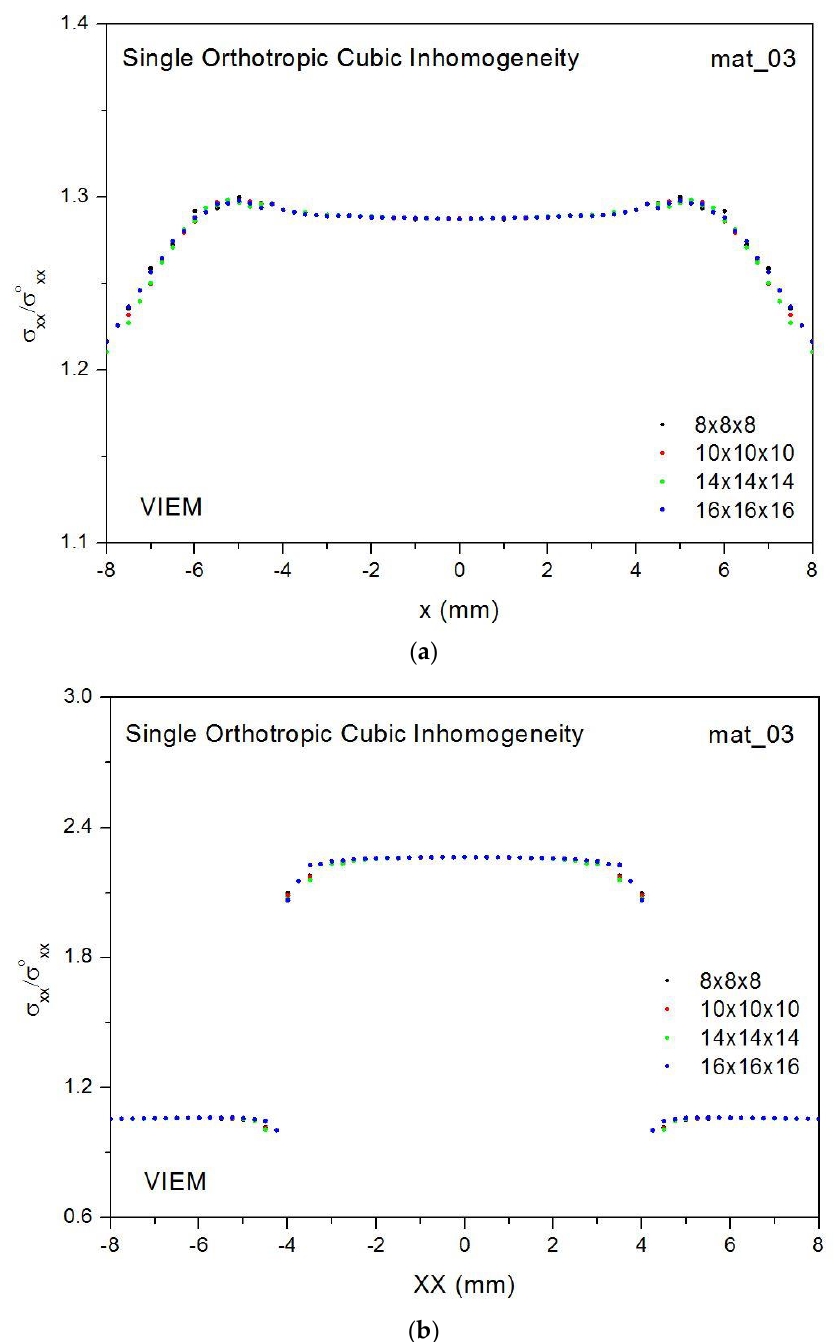
Figure 11. Numerical results using the volume integral equation method (VIEM) for the normalized tensile stress component (σ xx /σ oxx ) along the x-axis and the XX-axis (−8 mm ≤ x, XX ≤ 8 mm) for Model_8 × 8 × 8, Model_10 × 10 × 10, Model_14 × 14 × 14 and Model_16 × 16 × 16 under uniform remote tensile loading. ( a ) x-axis; ( b ) XX-axis.